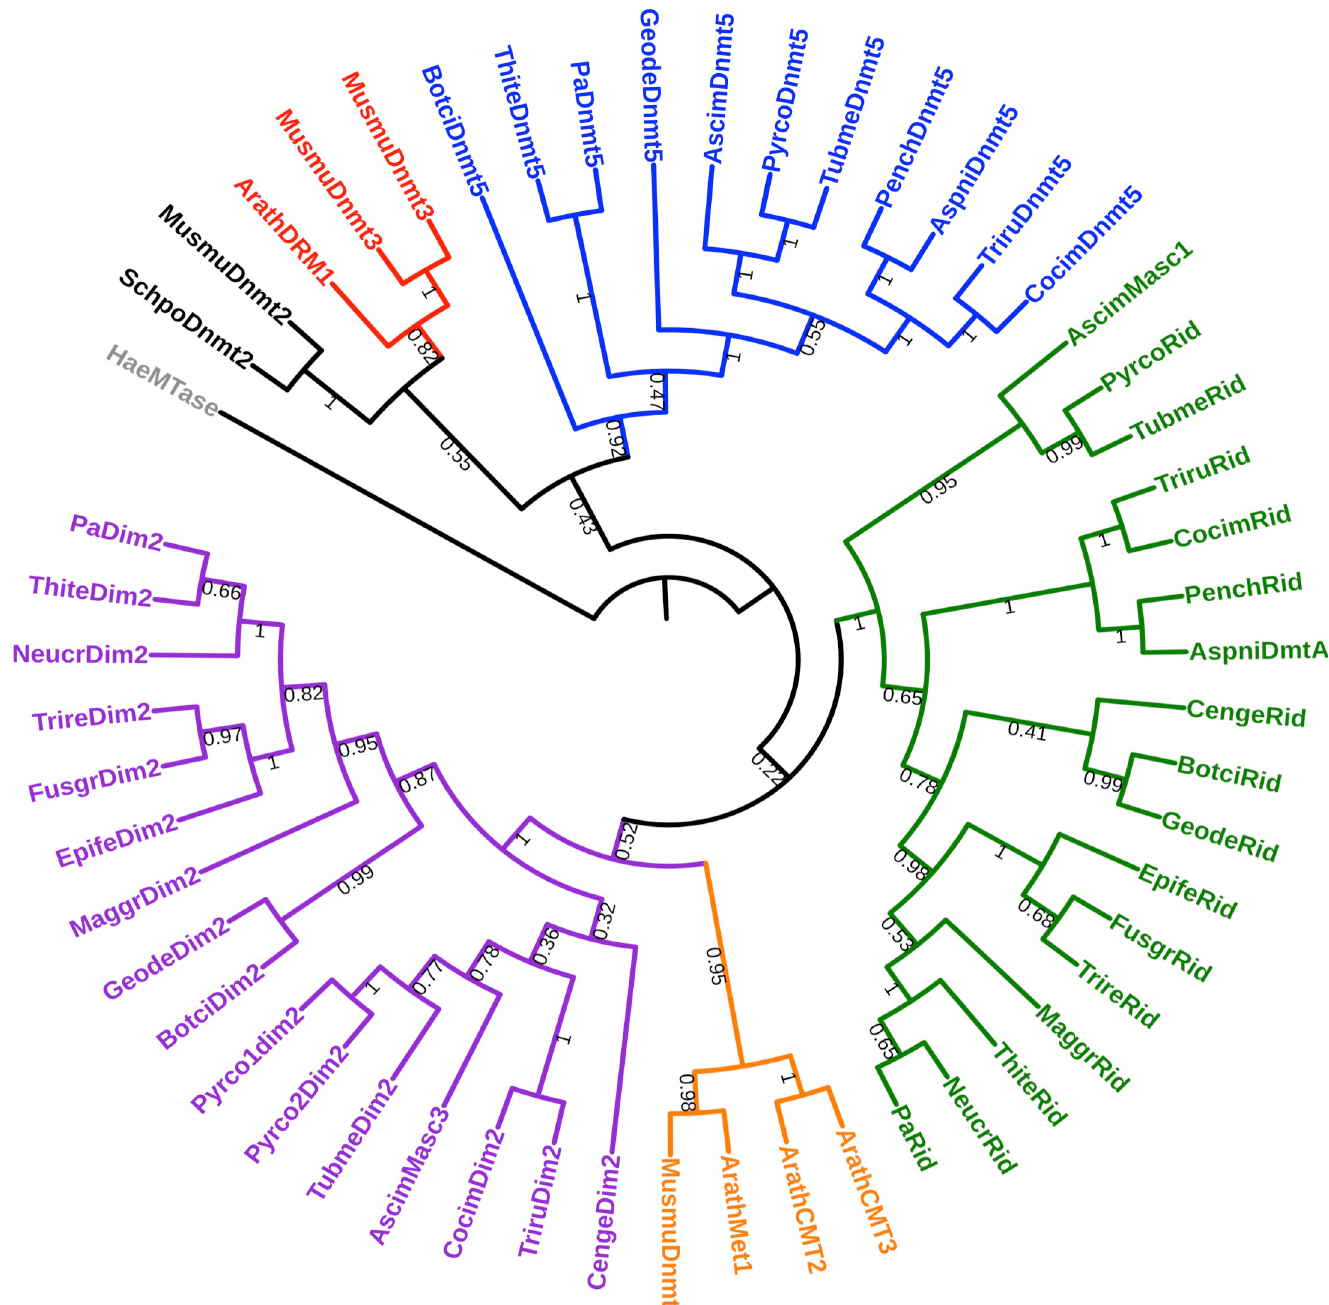
Fig 2. Phylogenetic analysis of mammal, plant and fungal DNA methyltransferases. The maximum likelihood tree resolved five groups i) the Dnmt1/Met1/CMT group (orange), ii) the Dnmt2, group (black) iii) the Dnmt3/DRM group (red) iv) the fungal Dim2-like group (purple) and v) the fungal-specific Rid-like group (green), vi) the DNMT5 group (blue). Haemophilus aegyptius (HaeMTase: WP_006996493.1) Arabidopsis thaliana (ArathMet1: NP_199727.1; ArathCMT2: NP_193637.2; ArathCMT3: NP_177135.1; ArathDRM1: NP_197042.2; ArathDRM2: NP_196966.2), Ascobolus immersus (AscimMasc3: